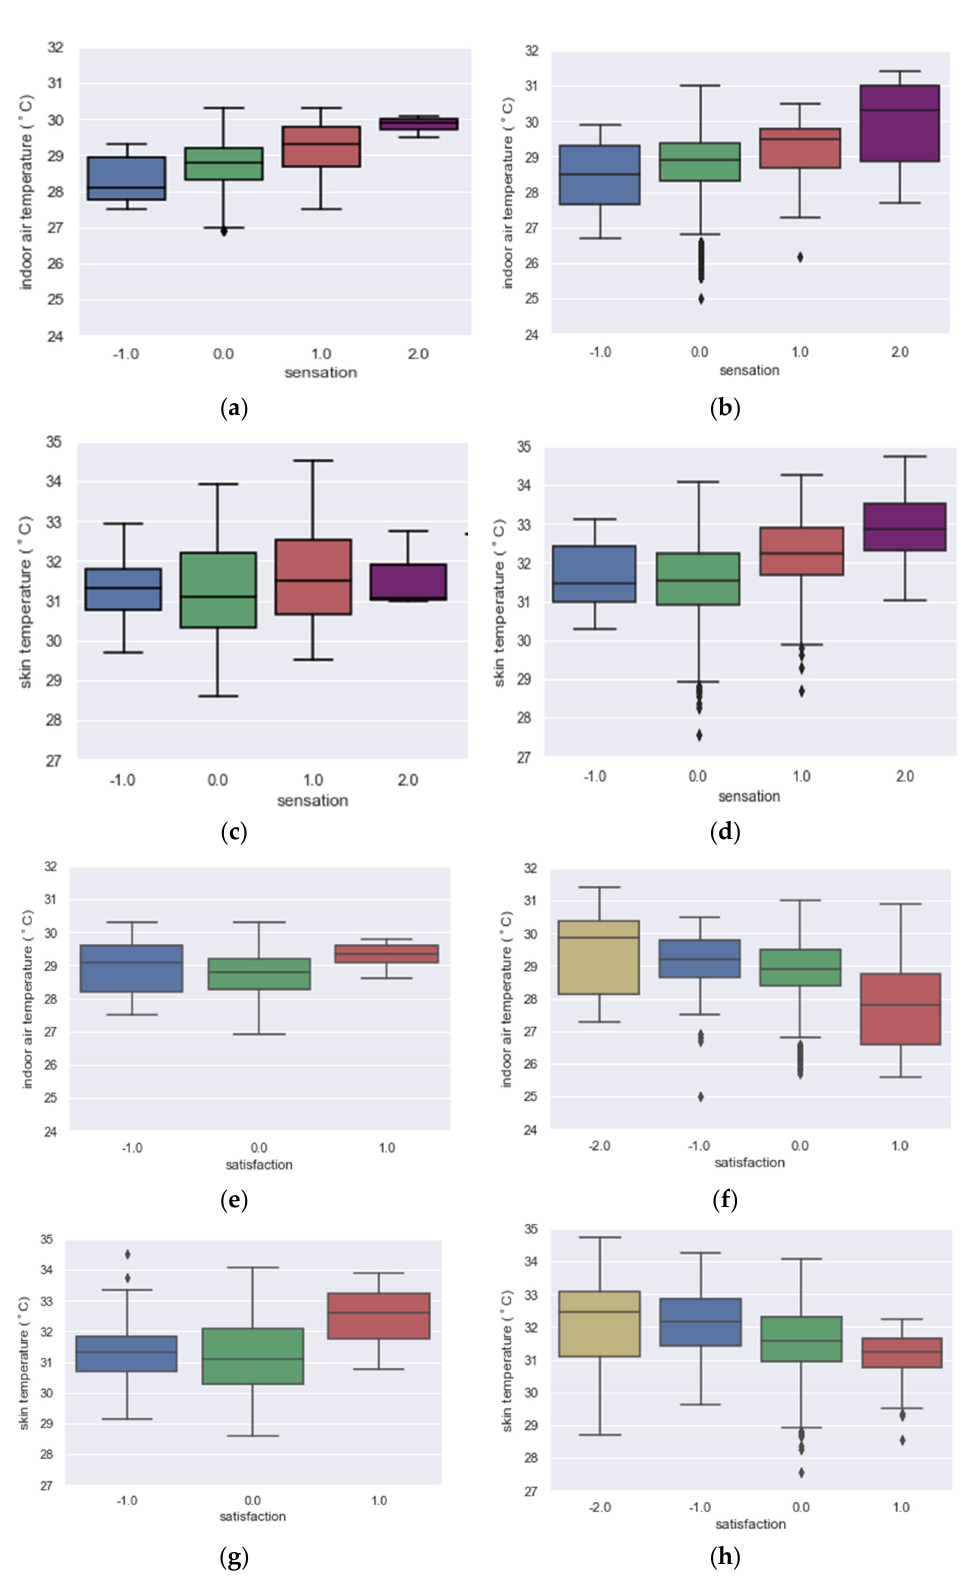
Figure 11. Relations between air/skin temperature and thermal sensation/satisfaction. ( a ) Air temperature vs. sensation of females; ( b ) air temperature vs. sensation of males; ( c ) skin temperature vs. sensation of females; ( d ) skin temperature vs. sensation of males; ( e ) air temperature vs. satisfaction of females; ( f ) air temperature vs. satisfaction of males; ( g ) skin temperature vs. satisfaction of females; ( h ) skin temperature vs. satisfaction of